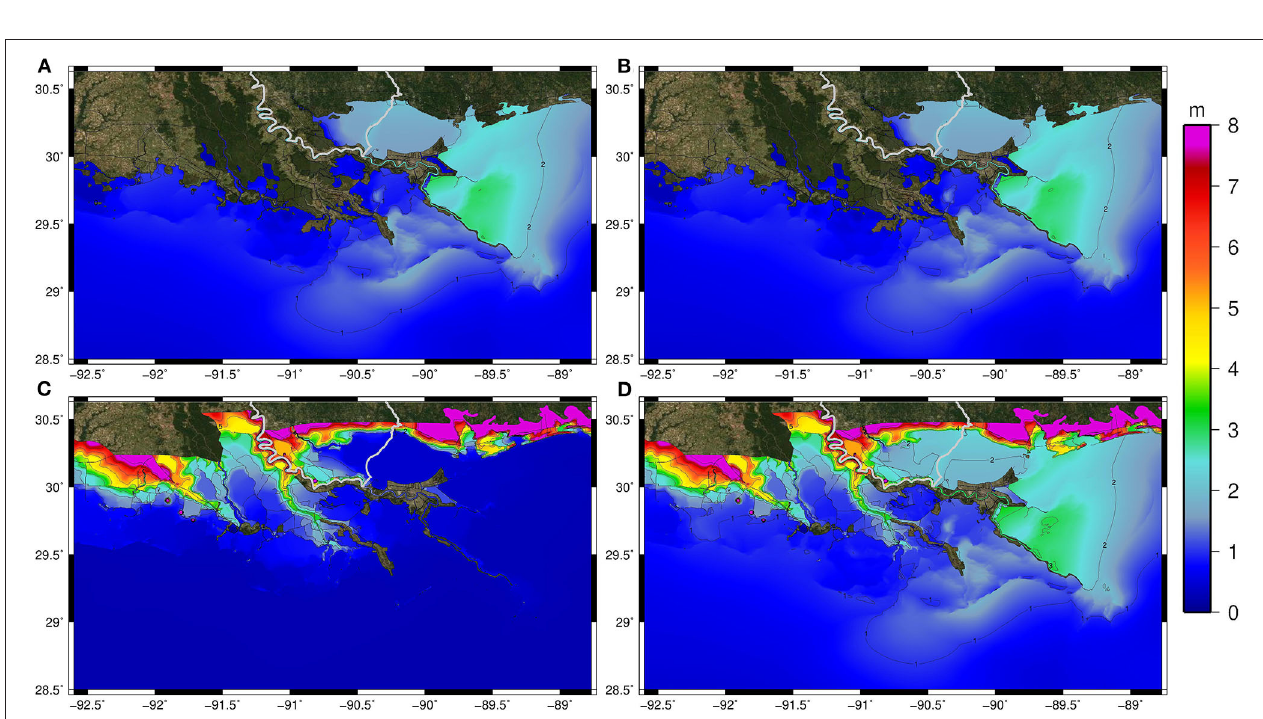
FIGURE 9 | Maximum of maximums (MOM) simulated peak water levels (m, NAVD88) for the Lake Maurepas 10-year TC events from (A) storm surge only (no rainfall), (B) storm surge and TC-driven rain, (C) antecedent rainfall only (no storm surge), and (D) antecedent rainfall, TC-driven rainfall, and storm surge in a single simulation.